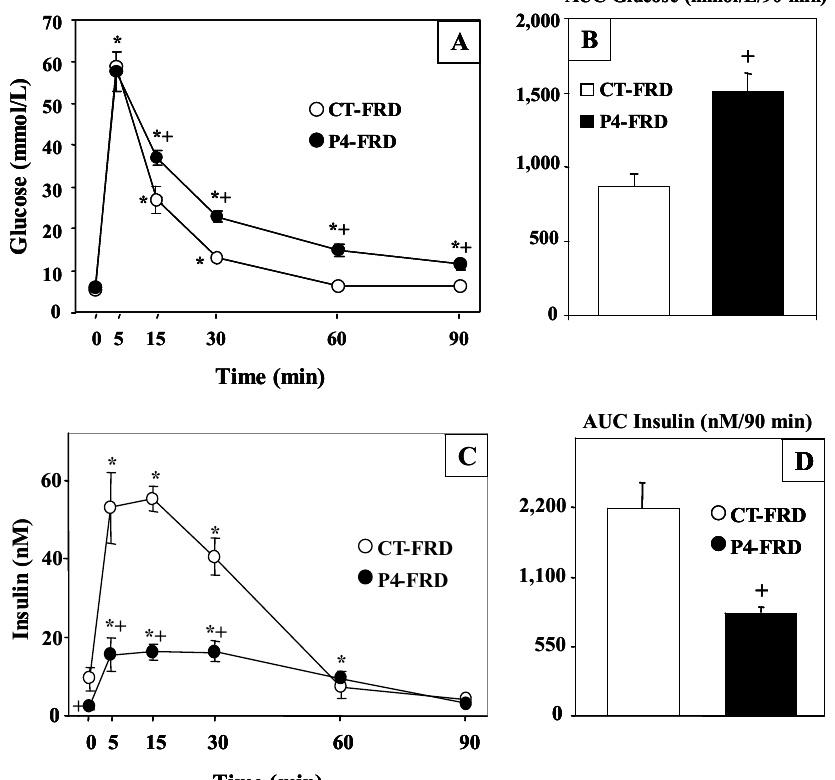
Figure 3. Circulating levels of glucose ( A ) and insulin ( C ) during the i.v.-GTT in CT and P4-treated rats fed a FRD. The area under the curve (AUC) throughout the test of circulating levels of glucose ( B ) and insulin ( D ) are also depicted. Values are means ± SEM, n = 6–7 animals per